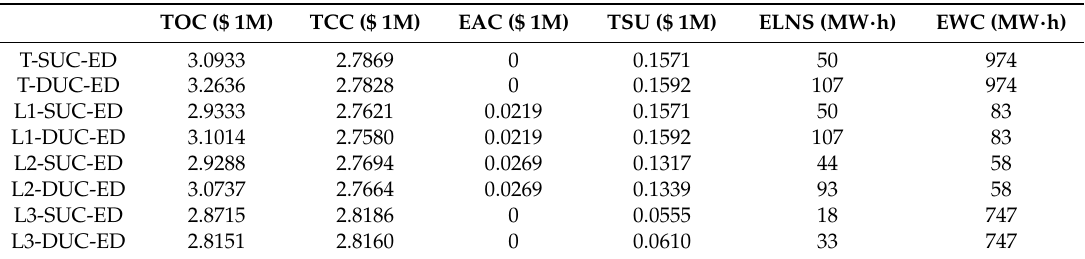
Table 9. The real-time operation performance for different UC